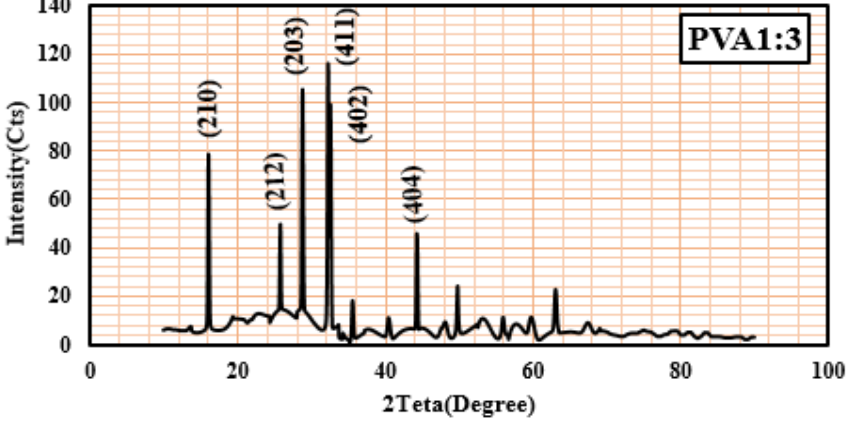
Figure 2. XRD patterns of KTP nanoparticles synthesized without and with different mole ratios of PVA as capping agent Table 1. Crystallite size, particle size and PDI for KTP nanoparticles obtained under different conditions Mole ratio of sample Type of capping agent capping